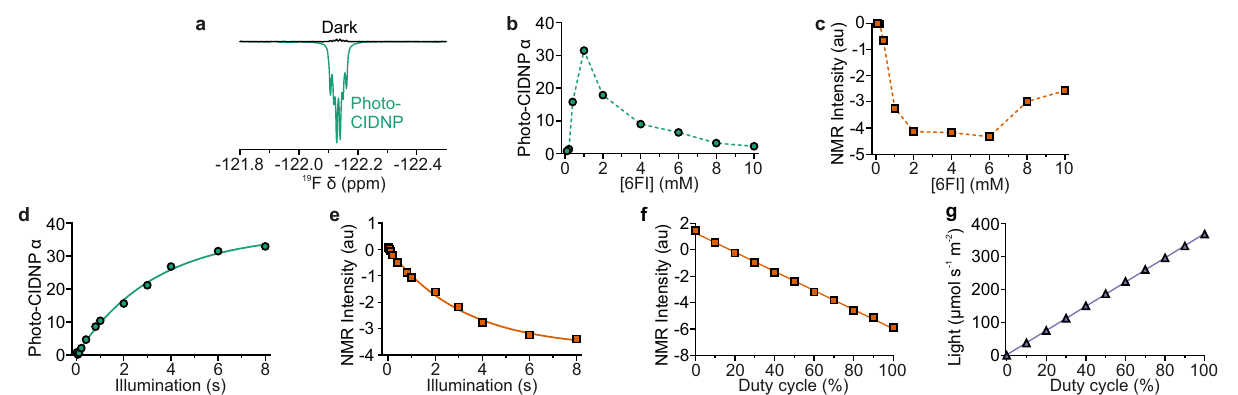
Fig. 2 Photo-CIDNP effect observed for 6FI molecule using the NMRtorch apparatus. a Maximum observed 6FI photo-CIDNP effect, with 1 mM 6FI and 0.4 mM FMN, following 6 s illumination with 460 nm light. Both dark and illuminated photo-CIDNP spectra were acquired with one scan, and are shown here overlaid. Effect of 6FI concentration (in the presence of 0.2 mM FMN) on b 19 F photo-CIDNP enhancement factor α and c NMR signal intensity, with 6 s illumination time. Effect of illumination time on d photo-CIDNP α and e signal intensity of 1 mM 6FI with 0.2 mM FMN, with exponential fi ts. f Effect of LED PWM (100 Hz) duty cycle on relative intensity of 6FI signal (at 6 mM, with 0.2 mM FMN present) recorded with 6 s illumination time. g The corresponding light intensity measured in PPFD units ex situ at the side of the sample with a photometer is also shown. The experimental data show linear dependence on duty cycle. All experiments recorded with single blue LED (460 nm, 3 W).